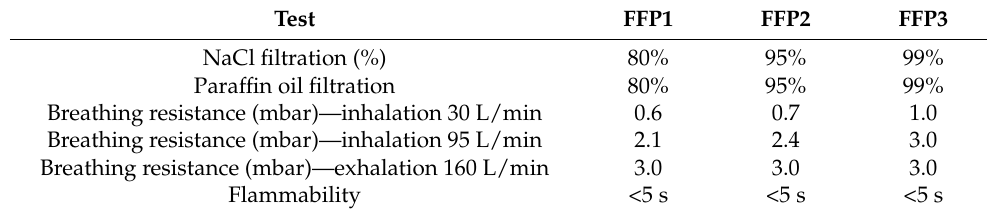
Table 2. Some performance requirements of respirators as per international standard EN 149:2001. Test